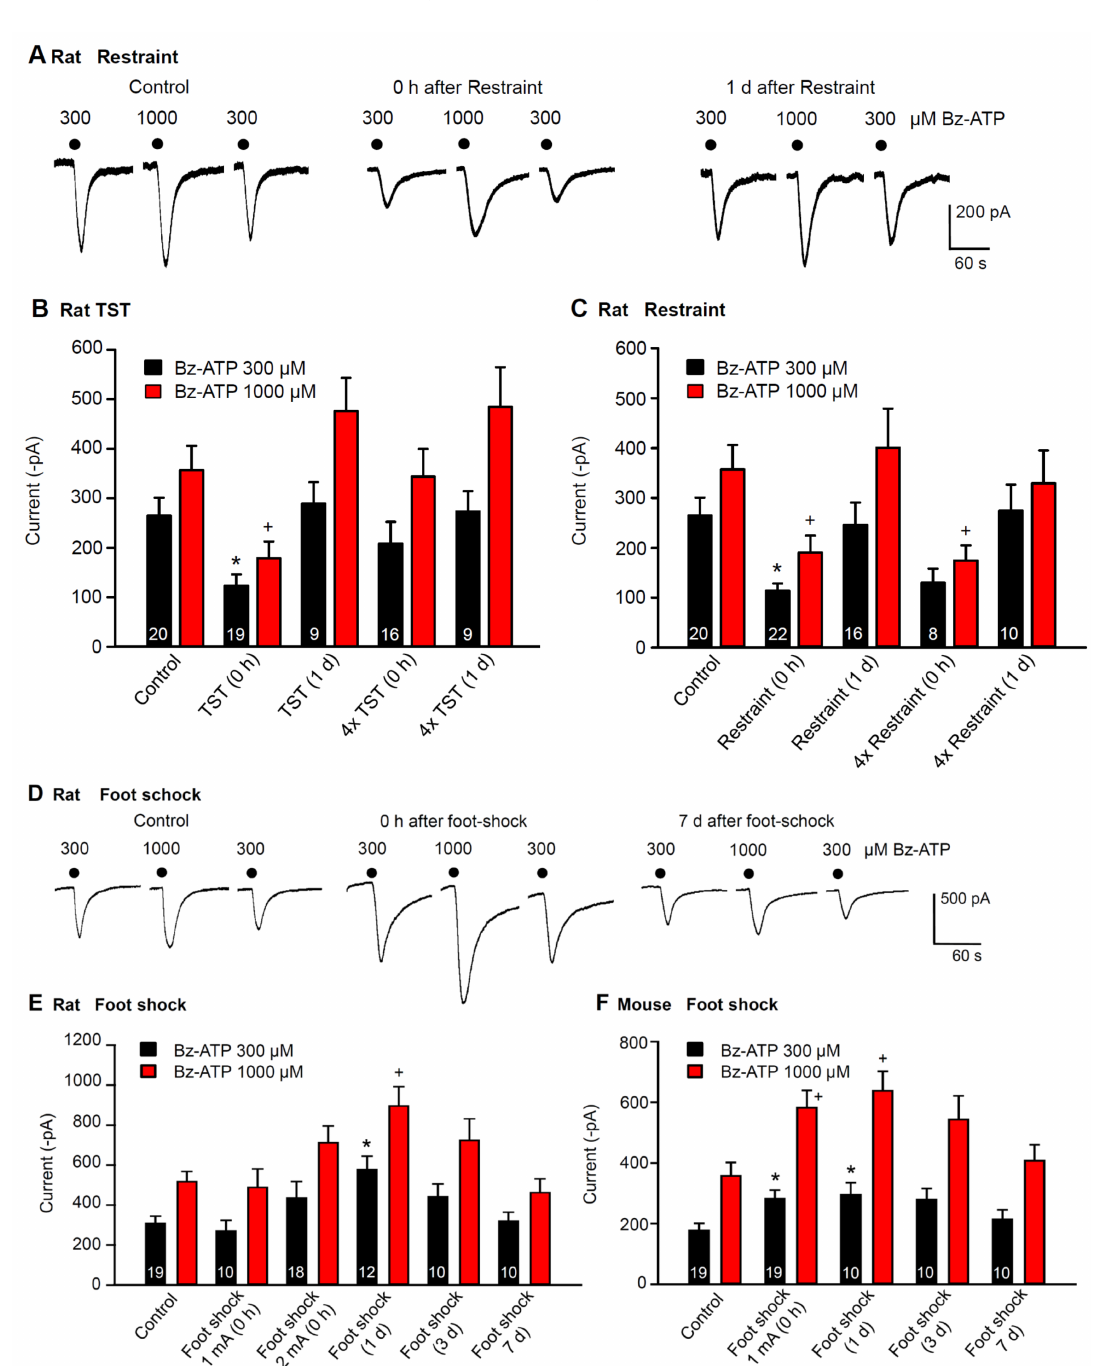
Figure 4. Effects of learned helplessness on Bz-ATP-induced current amplitudes in hippocampal CA1 astrocytes of rats and mice. ( A ) current responses of astrocytes to Bz-ATP (300, 1000 µ M), prepared from rats which underwent no stress (control), or restraint stress, immediately or 1 day before preparing their hippocampal slices for recordings. Representative tracings. ( B ) mean ±